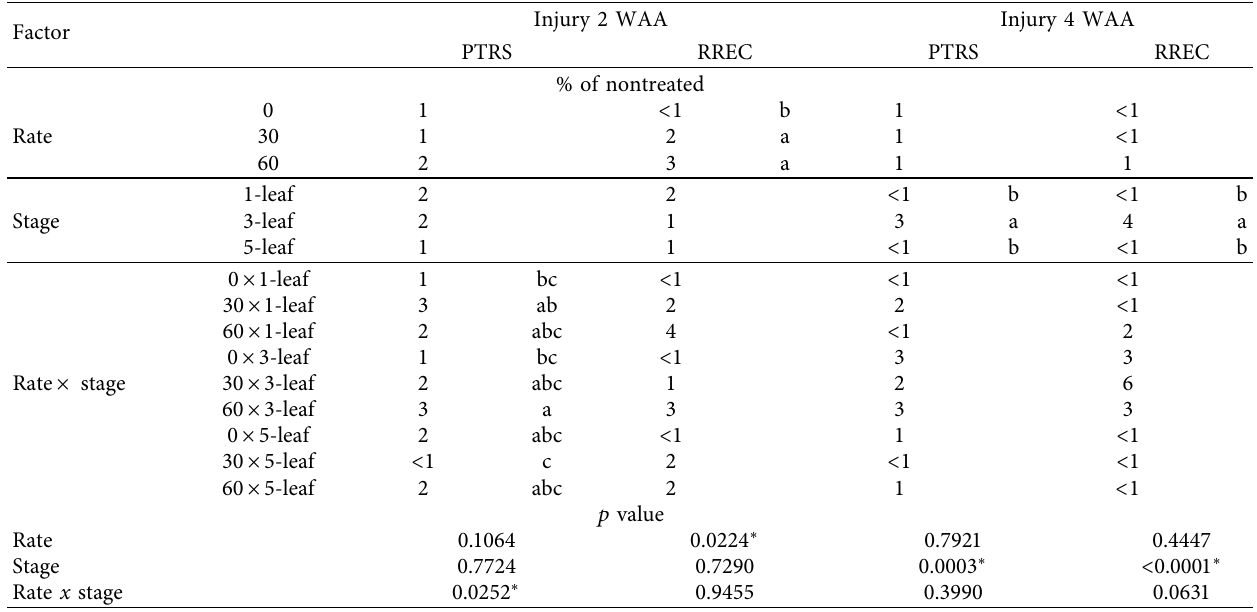
Table 1: Rice injury for CL111 as influenced by florpyrauxifen-benzyl rate applied with imazethapyr at various rice growth stages a,b,c . Factor